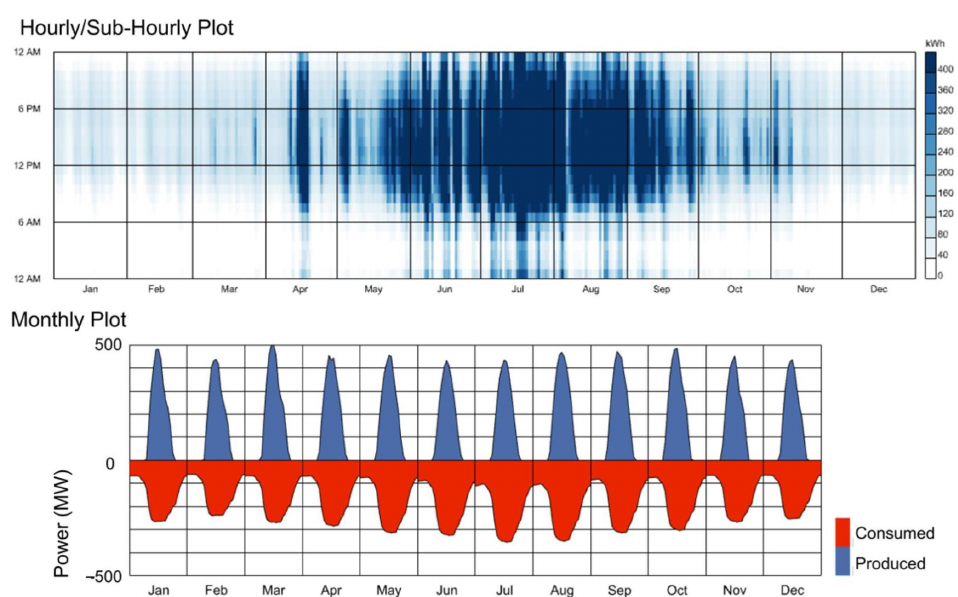
Figure 7. Example Dragonfly temporal